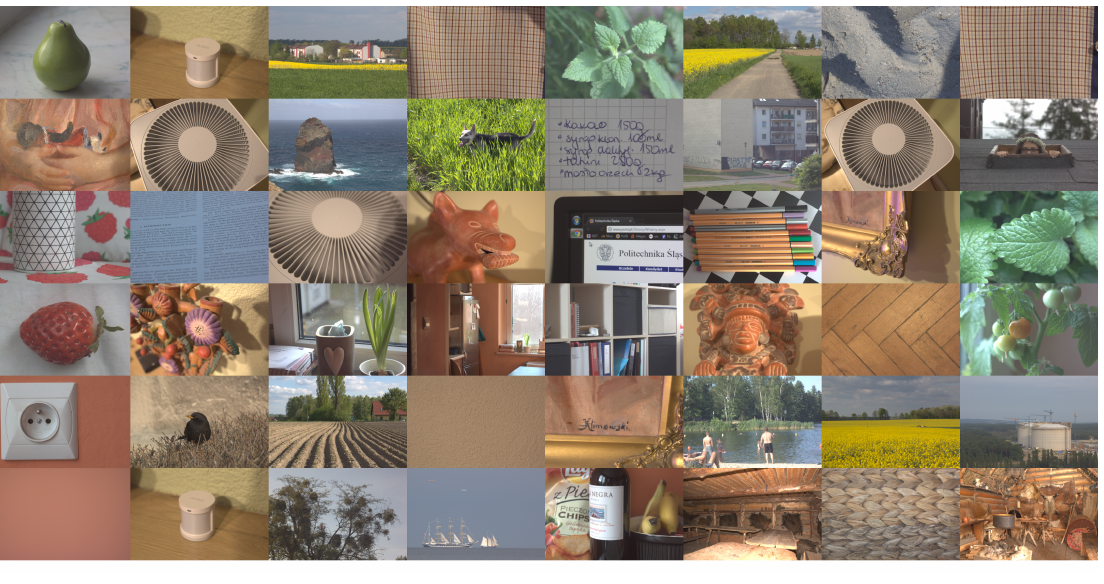
Figure 9. Set of test images.